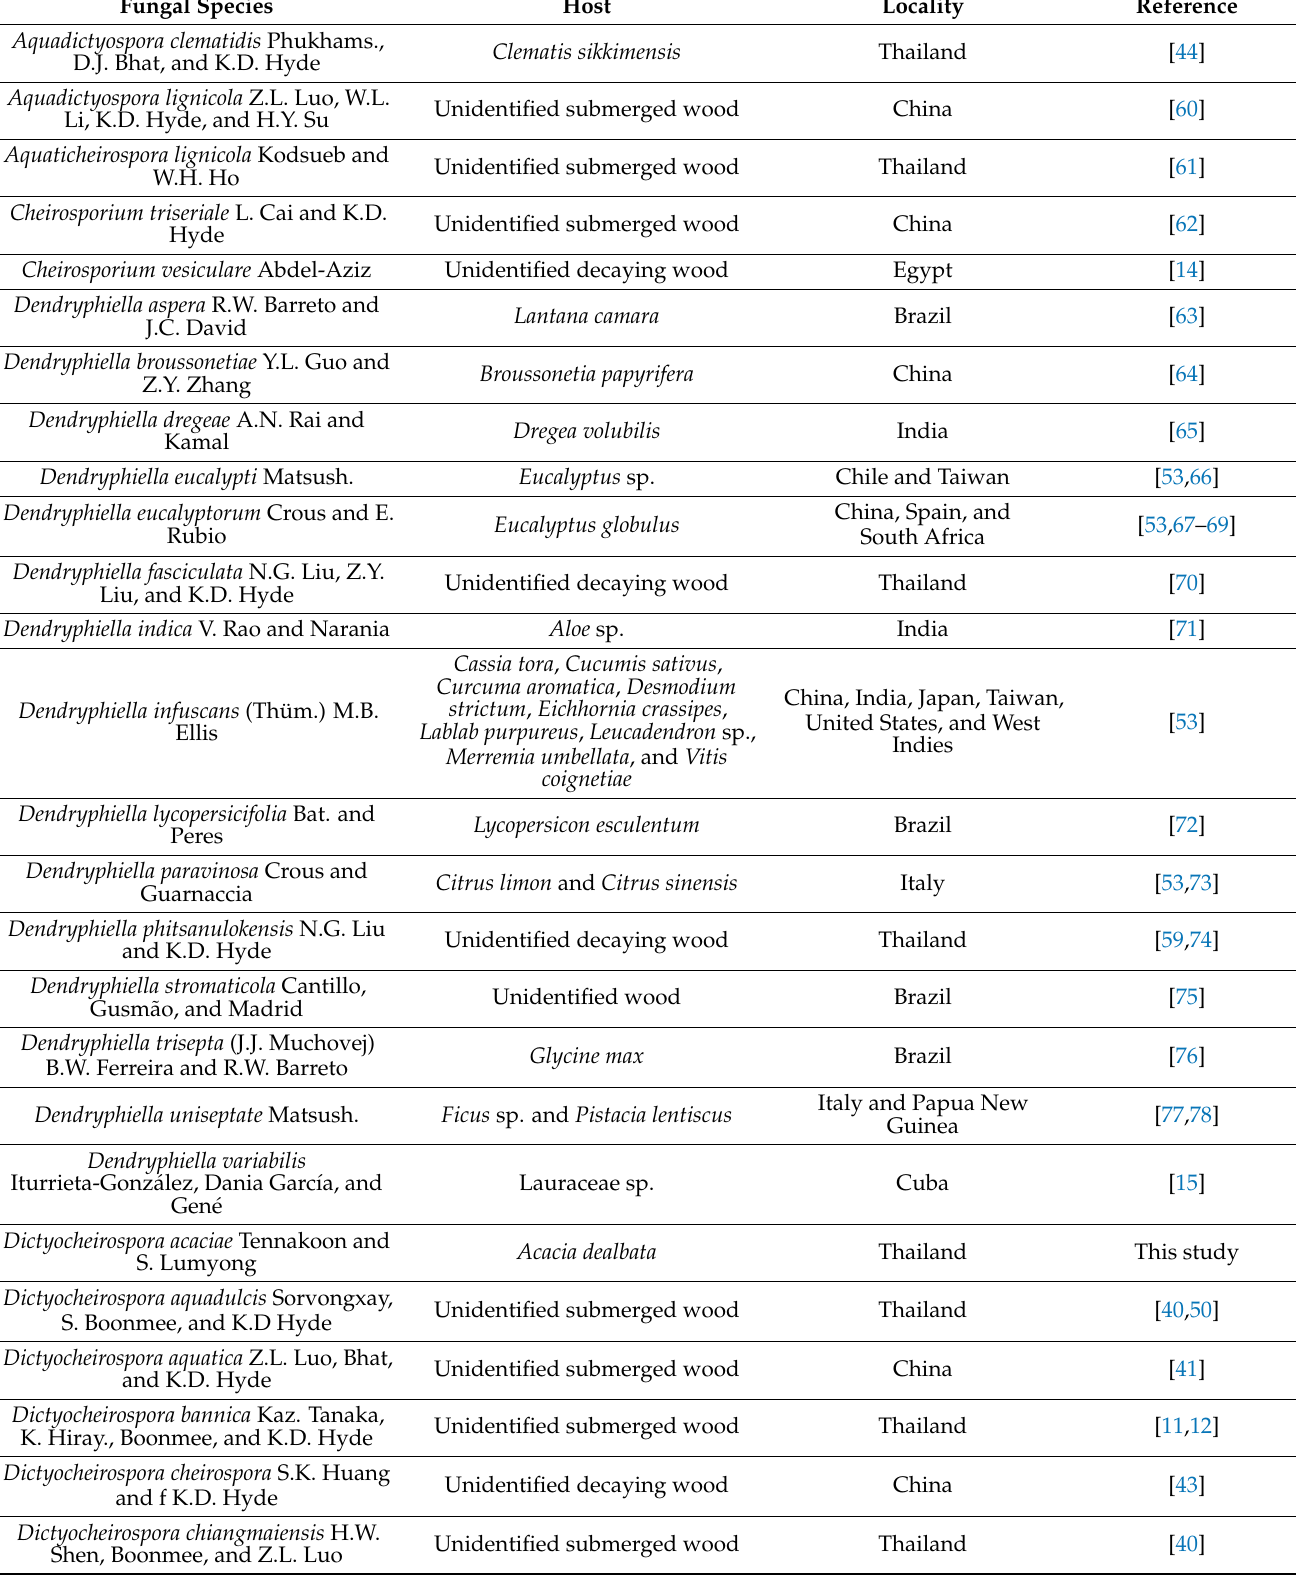
Table 3. Host association and geographical distribution of reported Dictyosporiaceae